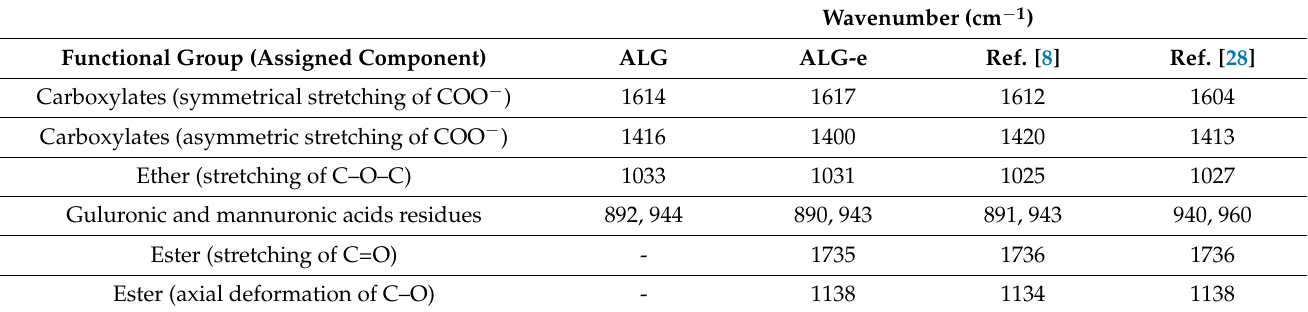
Table 2. Functional group assignment from FTIR Spectra of esterified (ALG-e) and pristine (ALG)